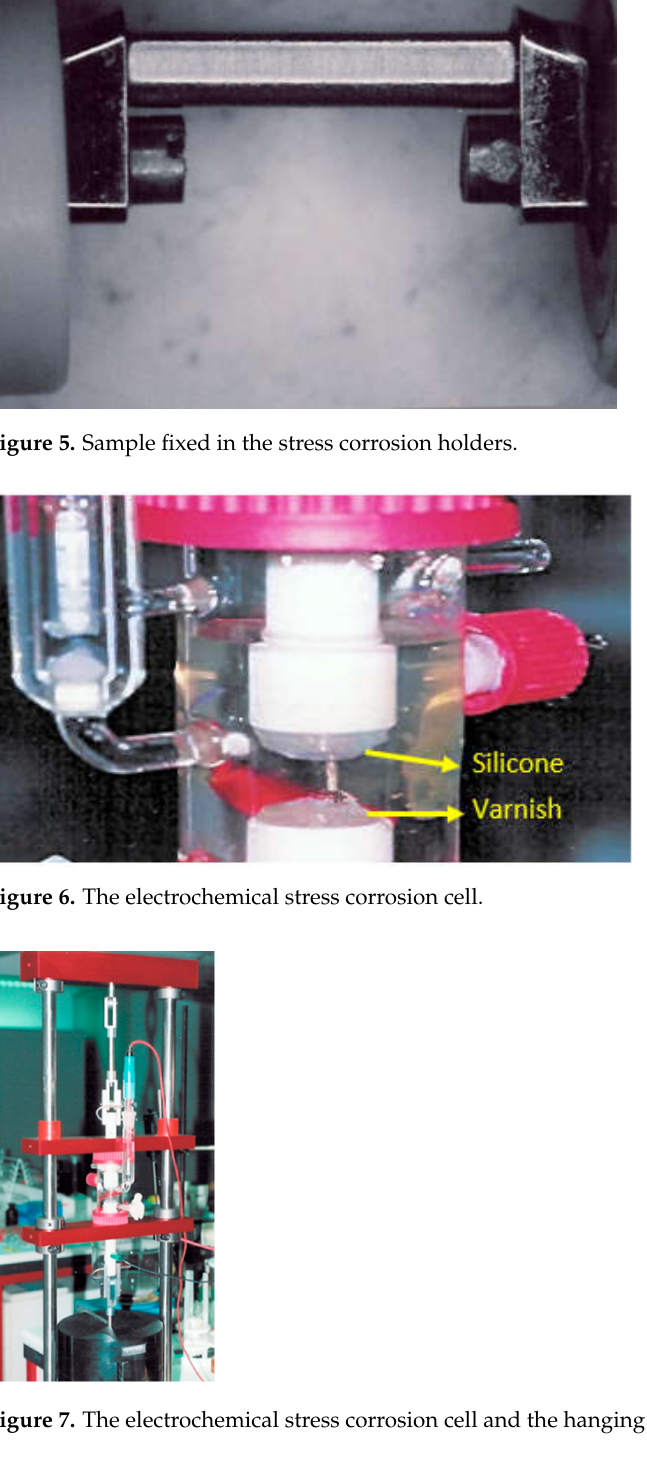
Figure 7. The electrochemical stress corrosion cell and the hanging weight system.